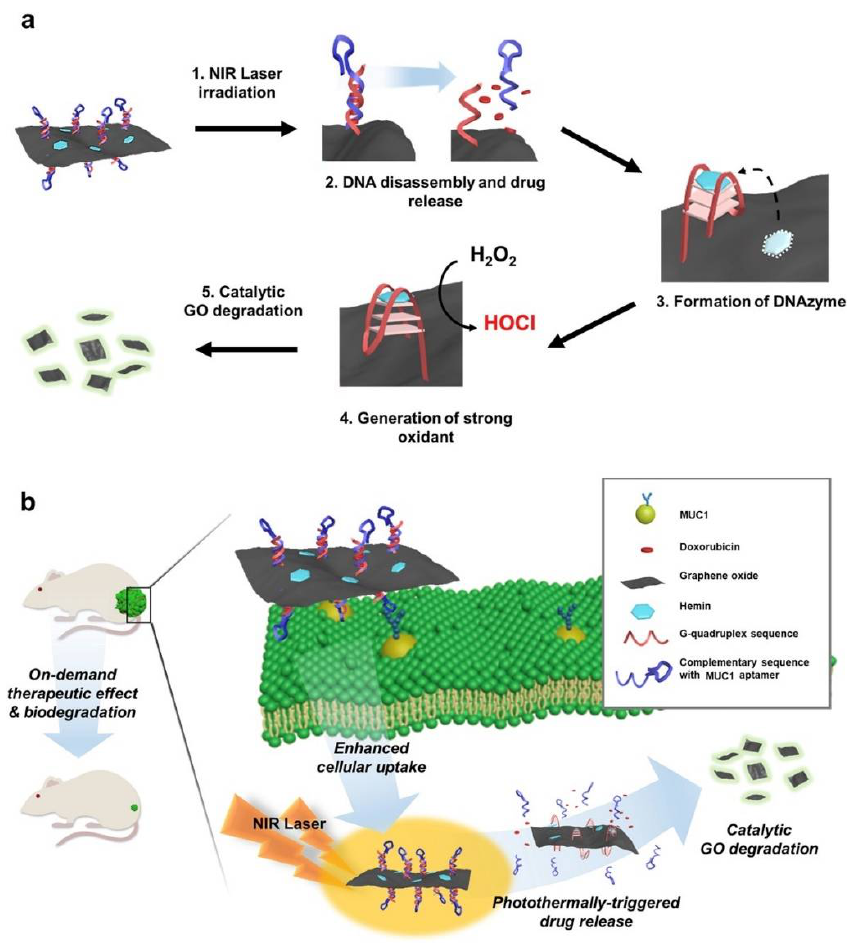
Figure 11. Schematic illustration self-catalytic GO-He-G4-M@DOX nano-system for cancer therapy conducted by a DNAzyme and controlled by photo-switch. ( a ) Design of GO-He-G4-M@DOX operated by photo-switch. ( b ) The systemic application of GO-He-G4-M@DOX can result in the controlled anticancer release and, subsequent, biodegradation into fluorescent small fragments of GO. Reprinted from Biomaterials, 263, Lee, H.; Kim, J.; Lee, J.; Park, H.; Park, Y.; Jung, S.; Lim, J.; Choi, H.C.; Kim, W.J., In vivo self-degradable graphene nano-medicine operated by DNAzyme and photo-switch for controlled anticancer therapy, 120402, Copyright (2020), with permission from Elsevier